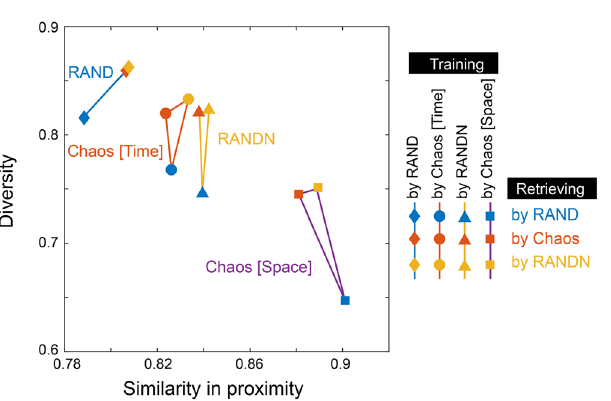
Figure 5. Analysis of the generator trained using chaos. Similarity in proximity and diversity when the output images were obtained from the generators trained using pseudorandom numbers and